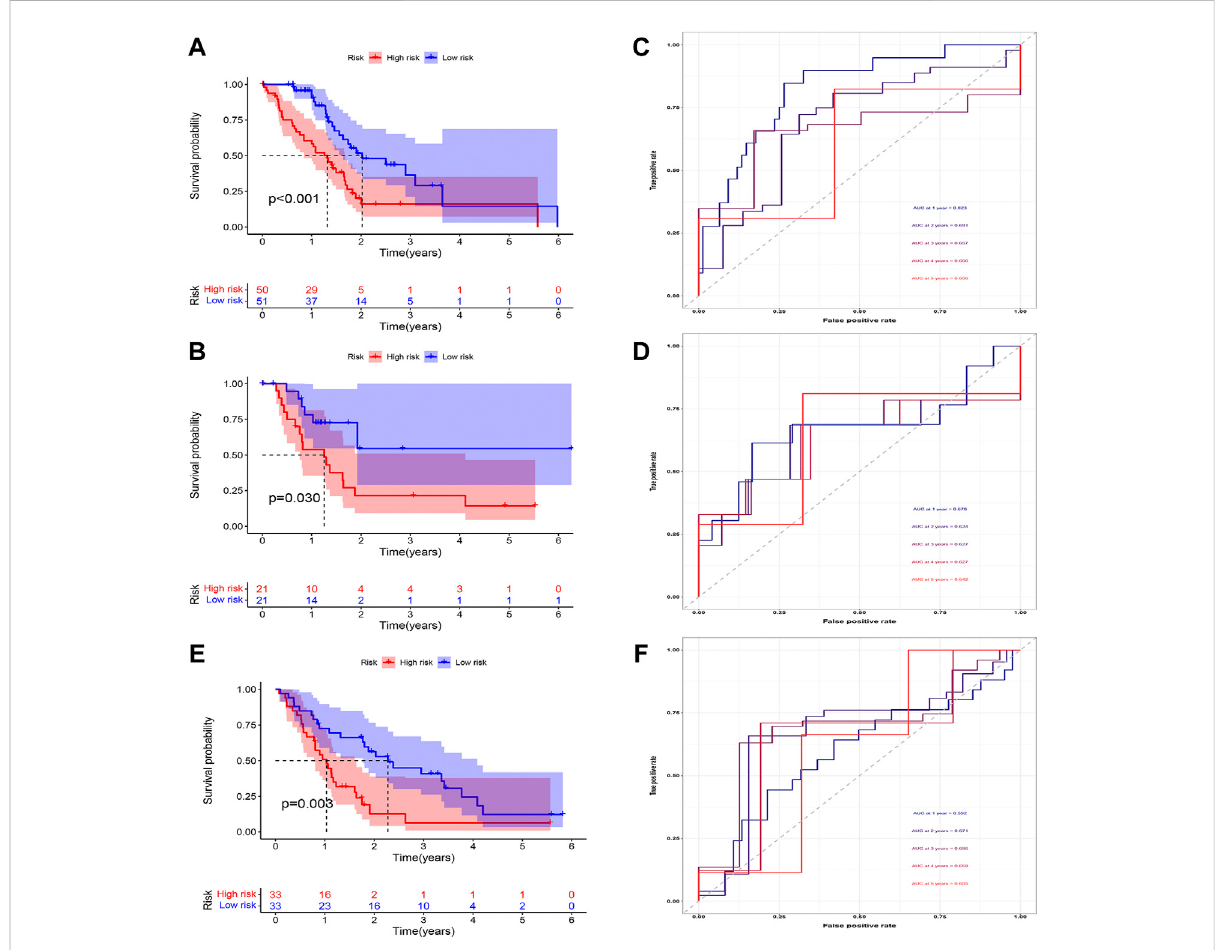
FIGURE 4 EvaluationofCDRG-basedprognosticmodel. (A,B) Wefoundthatpatientsinthehigh-riskgrouphadapoorerprognosisinboththetraining (A) andtest (B) cohorts( p < 0.05). (C,D) WefoundthattheAUCinbothcohortswasbasicallybetween0.6and0.7. (E,F) Inthevalidationcohort,thehigh- risk patients had a worse prognosis and the AUC was between 0.6 and